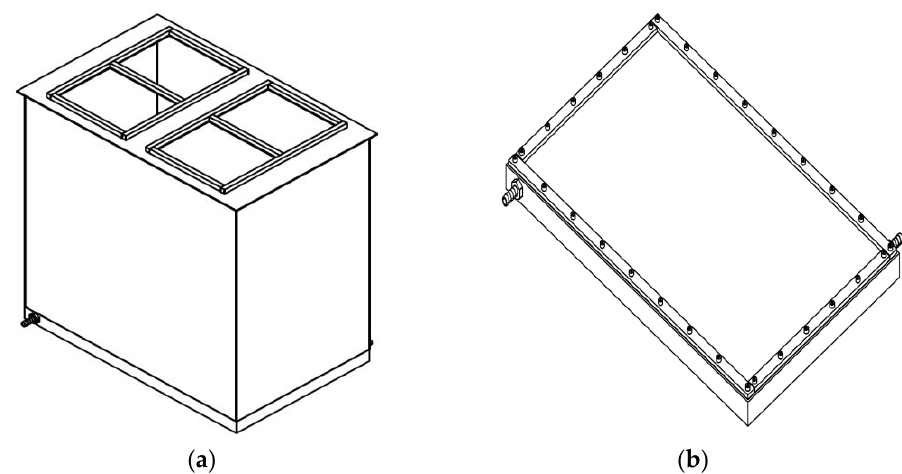
Figure 1. Outline of measuring the stand: ( a ) a dome on a cold plate; and ( b ) a test cold plate or PVT minimodule.